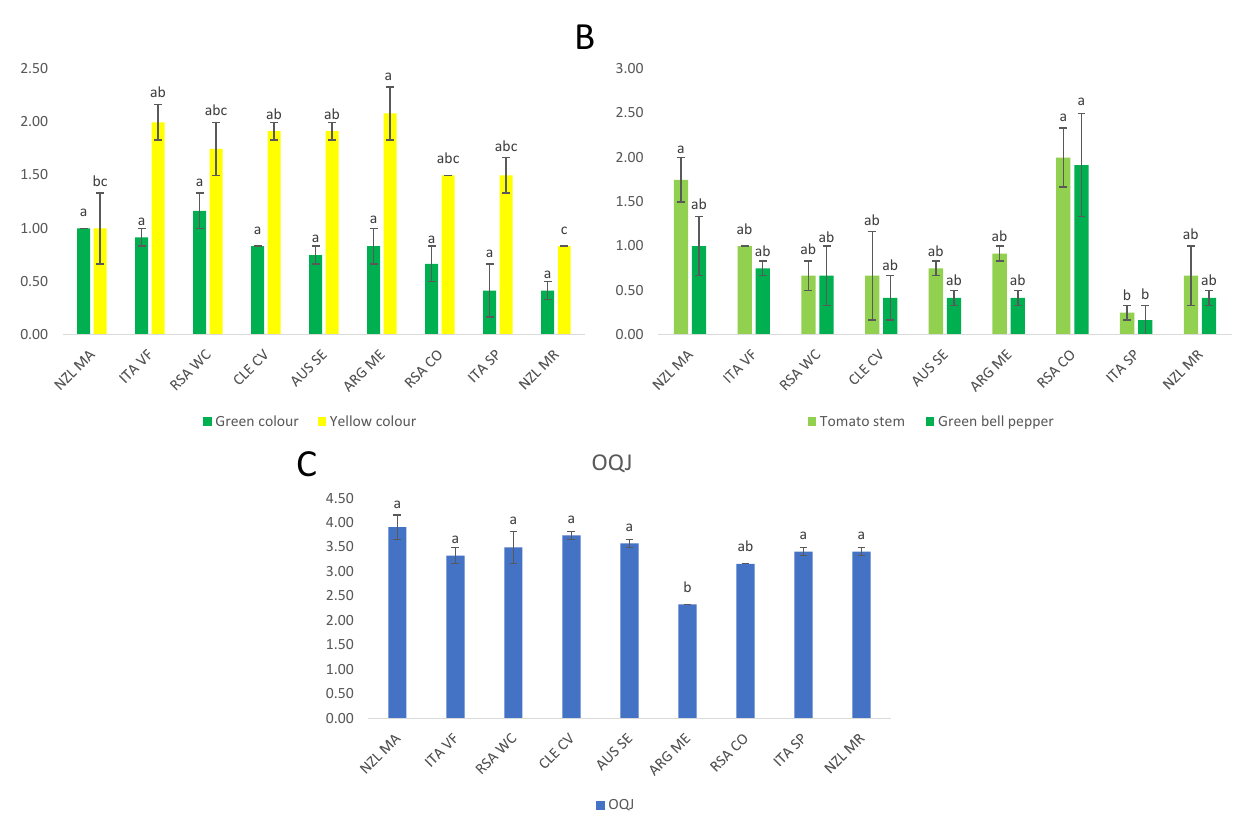
Figure 2. Significant sensory variables according to one-way ANOVA for Sauvignon Blanc data. The bars indicate the average between the two duplicates for the different sensory attributes (also for the standard deviation); different letters show significant differences among groups obtained by the ANOVA. ( A ) Significantly different colour attributes, ( B ) Significantly different aroma attributes. ( C ) Significantly different Overall Quality Judgement (OQJ). Letters a–c indicate groupings found by Tukey’s post-hoc